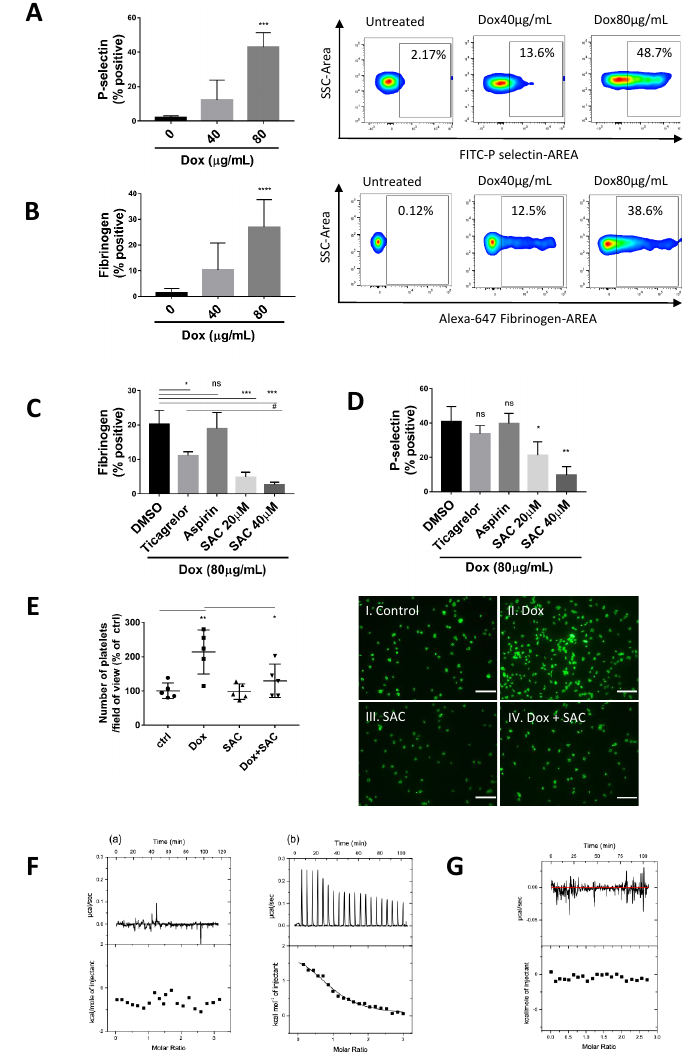
Figure 1. Dox-induced Platelet Activation Inhibited by SAC. Diluted mouse PRP was incubated with Dox for 25 min at 37 ◦ C. Platelet activation was determined by flow cytometry using anti-P- selectin antibody ( A ) and Alexa 647-conjugated Fibrinogen binding ( B ). Data are shown as the per- centage of positive platelets. ( C , D ) Effects of pretreatment with P2Y12 inhibitor Ticagrelor (0.1 µ M), TxA2 inhibitor Aspirin (6 mM), or SAC (20 µ M, 40 µ M) on Dox (80 µ g/mL)-induced murine platelet activation measured by P-selectin ( C ) and Fg binding ( D ) with flow cytometry. ( E ) Murine platelet spreading over immobilized fibrinogen examined by confocal imaging and number of adherent platelets per field of view quantified using Analyze Particles function in ImageJ/Fiji software. Scale bars = 64 µ m (40 × . Representative images of 3 separate experiments displayed. n ≥ 3 for all experiments. ( F ) ITC thermogram showing dissociation of ( a ) 80 µ g/mL doxorubicin and ( b ) 160 µ g/mL doxorubicin in Tyrode buffer. ( G ) ITC thermogram showing no interaction between fibrinogen and doxorubicin. For each, the top shows the raw titration data showing the heat resulting from each injection of ligand into buffer solution. The bottom shows the integrated heat plot after cor- recting for the heat of dilution. Data displayed as mean ± SD. Statistical significance determined by one-way ANOVA. (# p < 0.05, * p < 0.05, ** p < 0.01, *** p < 0.001, and **** p < 0.0001, ns = not significant). PRP = platelet-rich plasma, Fg = fibrinogen, Ctrl =